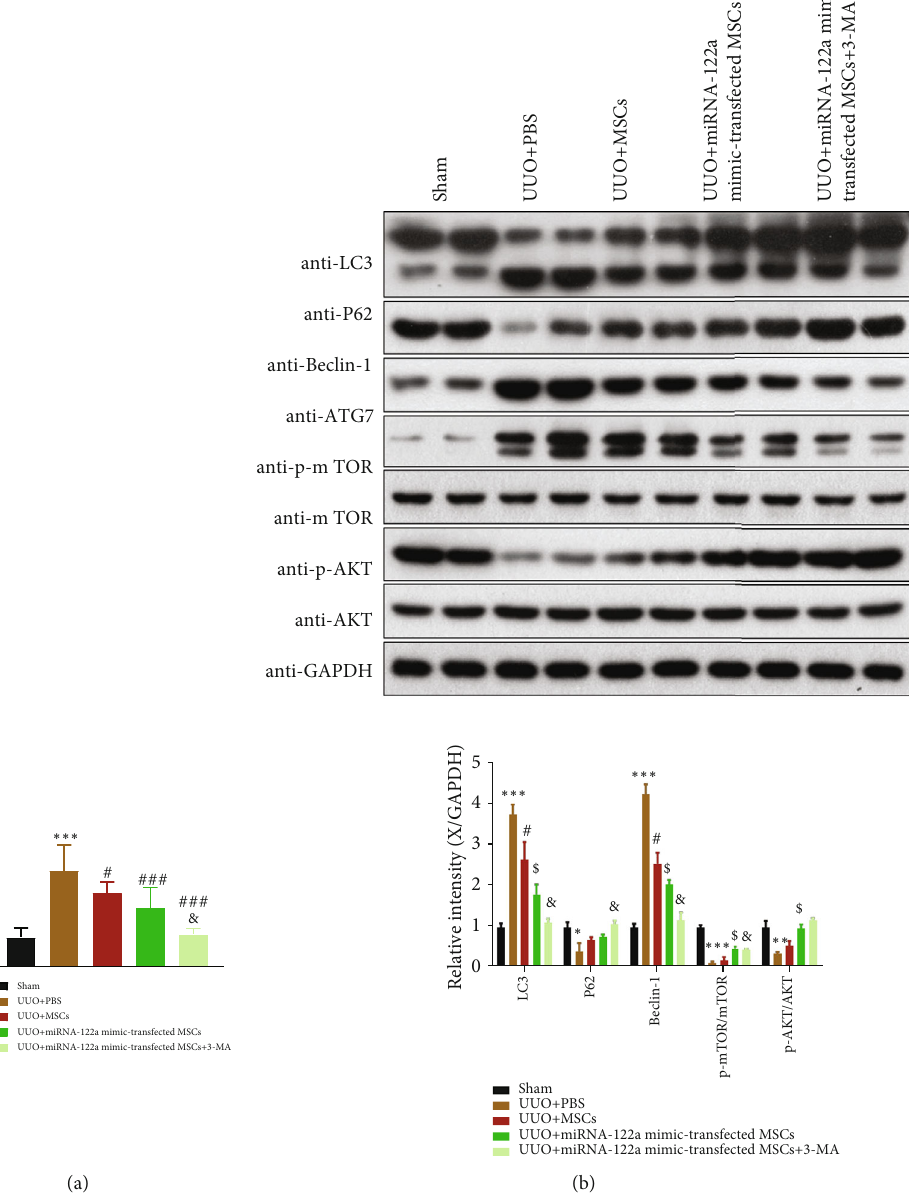
Figure 6: Unilateral ureteral obstruction- (UUO-) induced changes in the levels of TGF- β 1, and expression of autophagy-related proteins, p-mTOR, and p-AKT was improved by miRNA-122a mimic-transfected MSC treatment in UUO-injured mice. (a) miRNA-122a mimic-transfected MSC treatment dramatically reduced the serum levels of TGF- β 1 in the sham and UUO groups at 7 days postinjury treated with either PBS vehicle, miRNA-122a mimic-transfected MSCs, and miRNA-122a mimic-transfected MSCs+3-MA ( n = 6 /group). (b) LC3II/I, p62, Beclin 1, ATG7, mTOR, p-mTOR, AKT, and p-AKT protein expression was evaluated by western blotting in UUO kidney tissue, and the quantitative analysis is shown on the right ( n = 3 independent experiments). The results are expressed as the mean ± SEM . Compared with the sham group, ∗∗∗ P < 0 : 001 , ∗∗ P < 0 : 01 , and ∗ P < 0 : 05 . Compared with the UUO+PBS group, ### P < 0 : 001 , ## P < 0 : 01 , and # P < 0 : 05